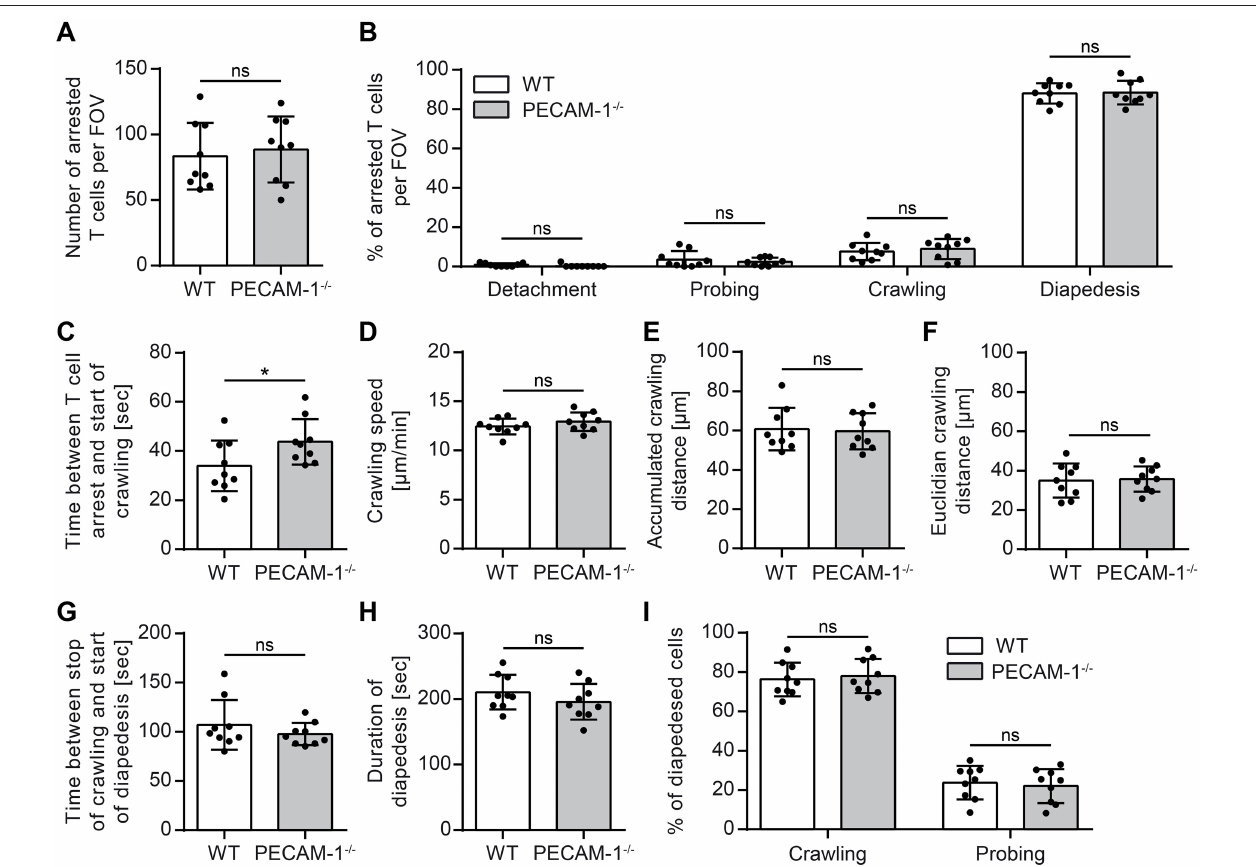
FIGURE 5 | Lack of endothelial PECAM-1 does not affect T-cell arrest or post-arrest T-cell crawling and diapedesis. Confluent WT and PECAM-1 − / − pMBMEC monolayers were stimulated with IL-1 β (20ng/ml) for 16–24h prior to live cell imaging. Activated encephalitogenic CD4 + T cells were allowed to arrest on pMBMECs at low flow (0. 1 dyn/cm 2 ). After 5min, the flow was increased to 1.5 dyn/cm 2 . For time-lapse videos, pictures were taken every 5s for a total of 20min. (A) The number of arrested T cells after increasing the flow rate (frame 60). (B) The behavior of each arrested T cell was determined for the subsequent 15min (frame 60 to 240) and assigned to one of the following categories: detachment, probing behavior, continuous crawling, diapedesis. (C) For all T cells eventually starting to crawl, the time span between initial arrest to the pMBMECs and the first frame of crawling was determined. (D–F) Each T cell crawling on the activated endothelial monolayer was tracked and the crawling speed (D) , accumulated crawling distance (E) , and Euclidian crawling distance (F) were calculated. (G) For all crawling T cells eventually starting to transmigrate, the time span between halt of movement and start of diapedesis was calculated. (H) For all T cells that finished diapedesis, the duration of diapedesis was calculated. (I) T cells, which eventually started to transmigrate, were classified according to their prior behavior: crawling or stationary. Data are derived from 9 videos per pMBMEC genotype performed in three independent experiments. Error bar, ± SD; FOV, field of view; ns, not significant. Reported statistics result from unpaired, two-tailed Student’s t -tests. Test statistics for (C): p = 0.0488, t (16) = 2.132 ( d = 1.066); * p < 0.05; ns, not